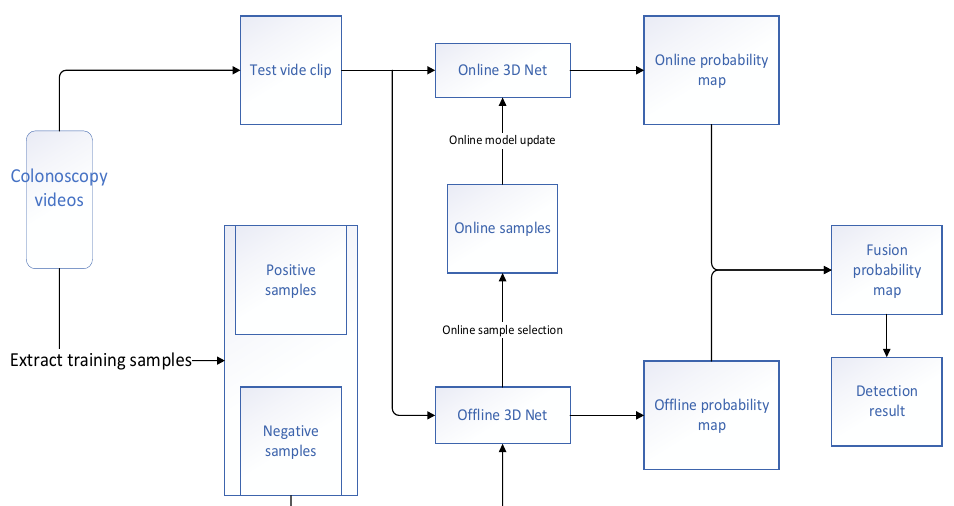
Figure 5. Flowchart of the online and offline 3D model proposed by Yu et al. [22].